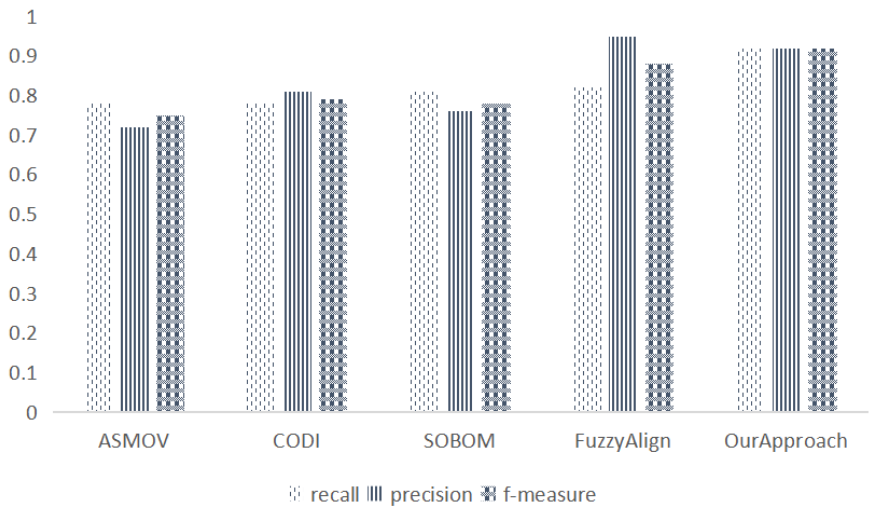
Figure 9. Comparison of Our Approach and the Advanced Sensor Ontology Matching Systems on CSIRO-SSN matching